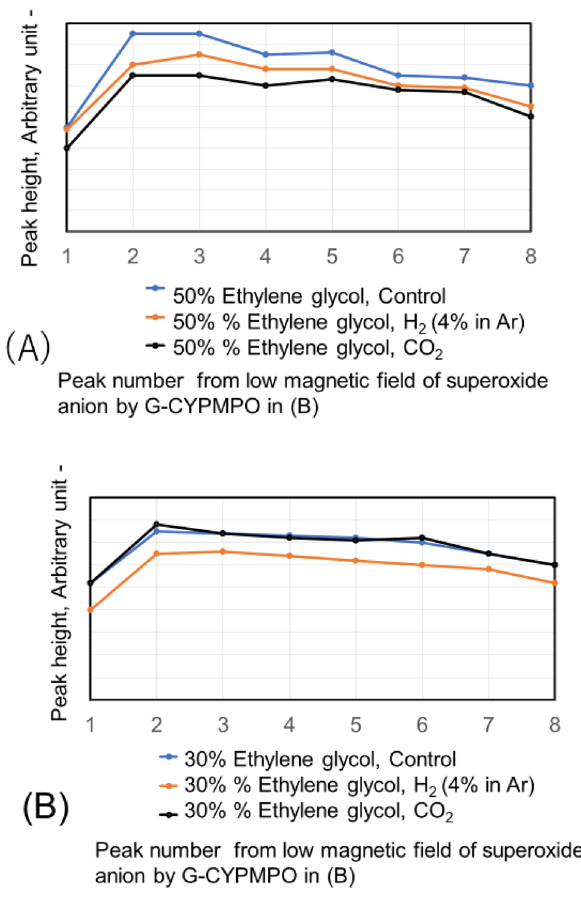
Figure 10. Peaks of superoxide anion radical with ESR in 30 and 50% ethylene glycol aqueous solution containing CO 2 and H 2 (4% in Ar)